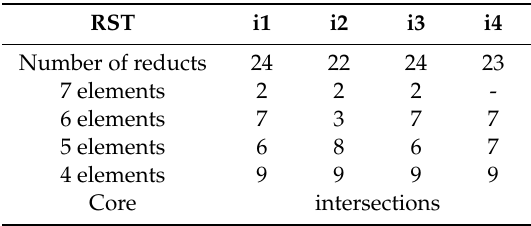
Table 5. Number, size, and cores of reducts designated using the RST method for the selection of road sections to the scale of